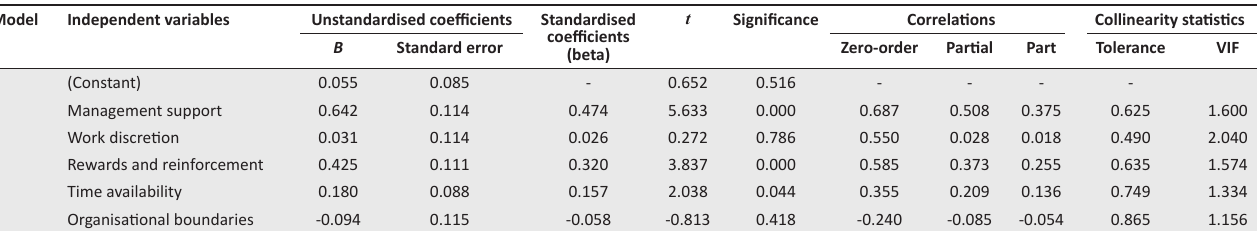
TABLE 7: Coefficients † Model